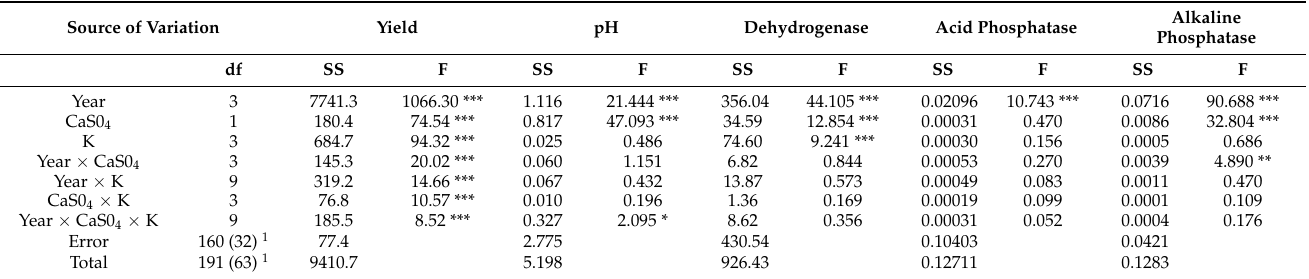
Table 2. Three-way ANOVA for analyzed depended variables.